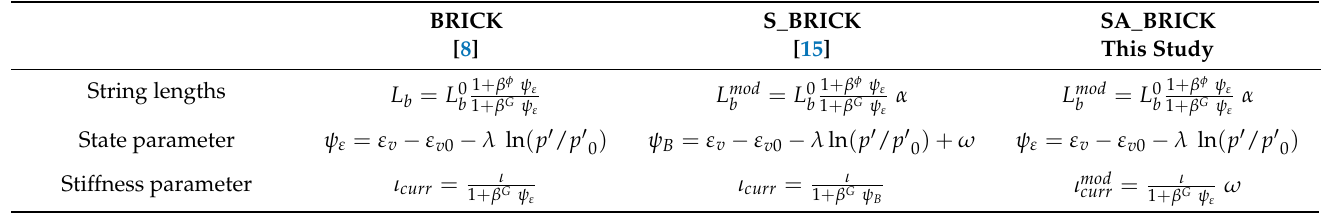
Table 2. Summary of the formulations of structure effects in the BRICK models in the form of mod- ification of string lengths, state and stiffness parameters.